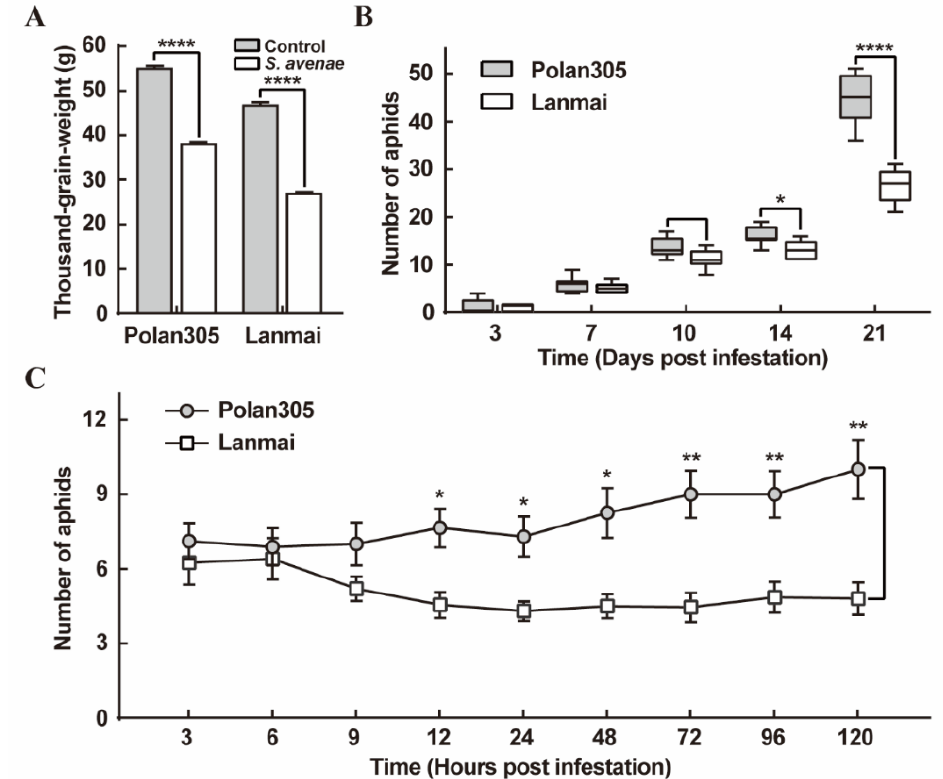
Figure 4. The performance of S. avenae on different wheat varieties. ( A ) The change of thousand-grain weight in resistant (Lanmai) and susceptible (Polan305) wheat varieties by S. avenae infestation. ( B ) The fecundity of S. avenae infesting on resistant (Lanmai) and susceptible (Polan305) seedlings. ( C ) S. avenae infestation preference between Lanmai and Polan305. Values are mean ± SE ( n = 9). *, **, **** indicate significant differences at p < 0.05, p < 0.01, p < 0.0001 (two-way ANOVA followed by Sidak’s multiple comparisons test),